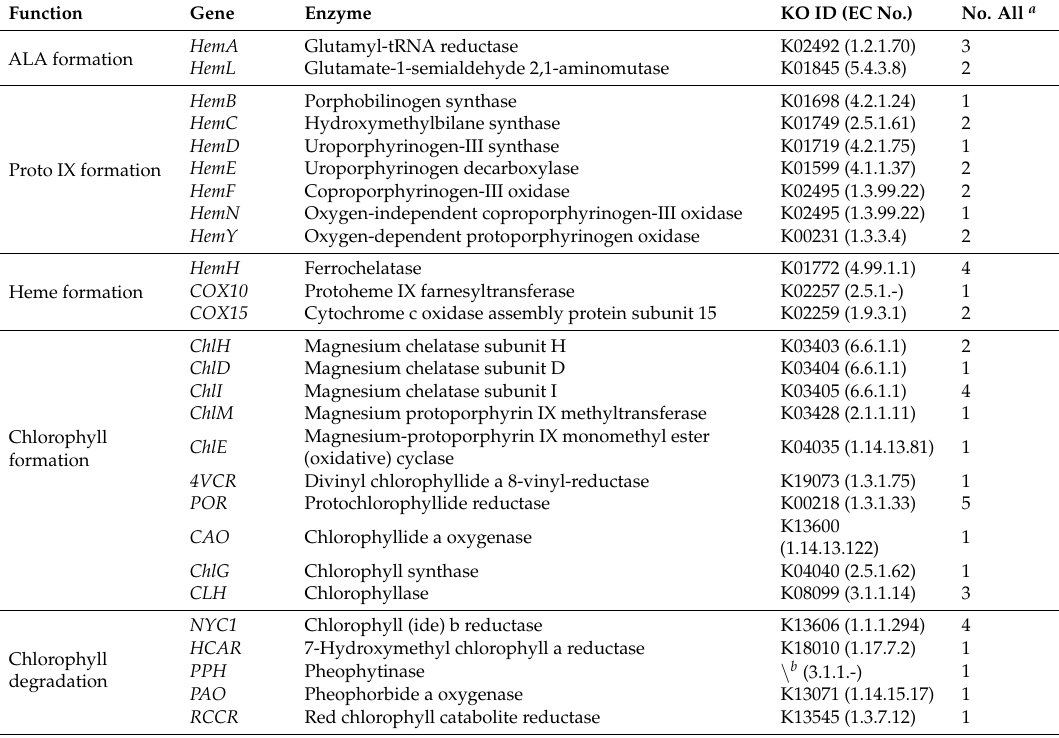
Table 3. Unigenes related to chlorophyll metabolic pathway in tepals of Chinese narcissus.